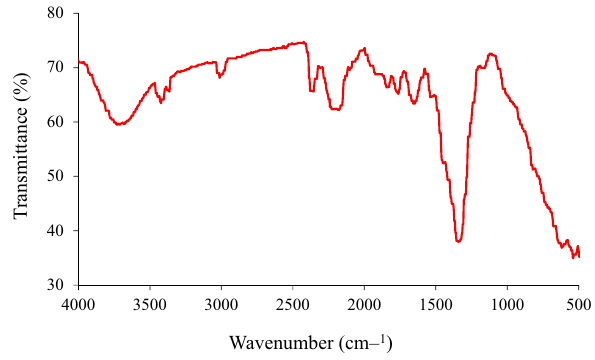
Fig. 1 FTIR spectrum of pseudo-stem banana